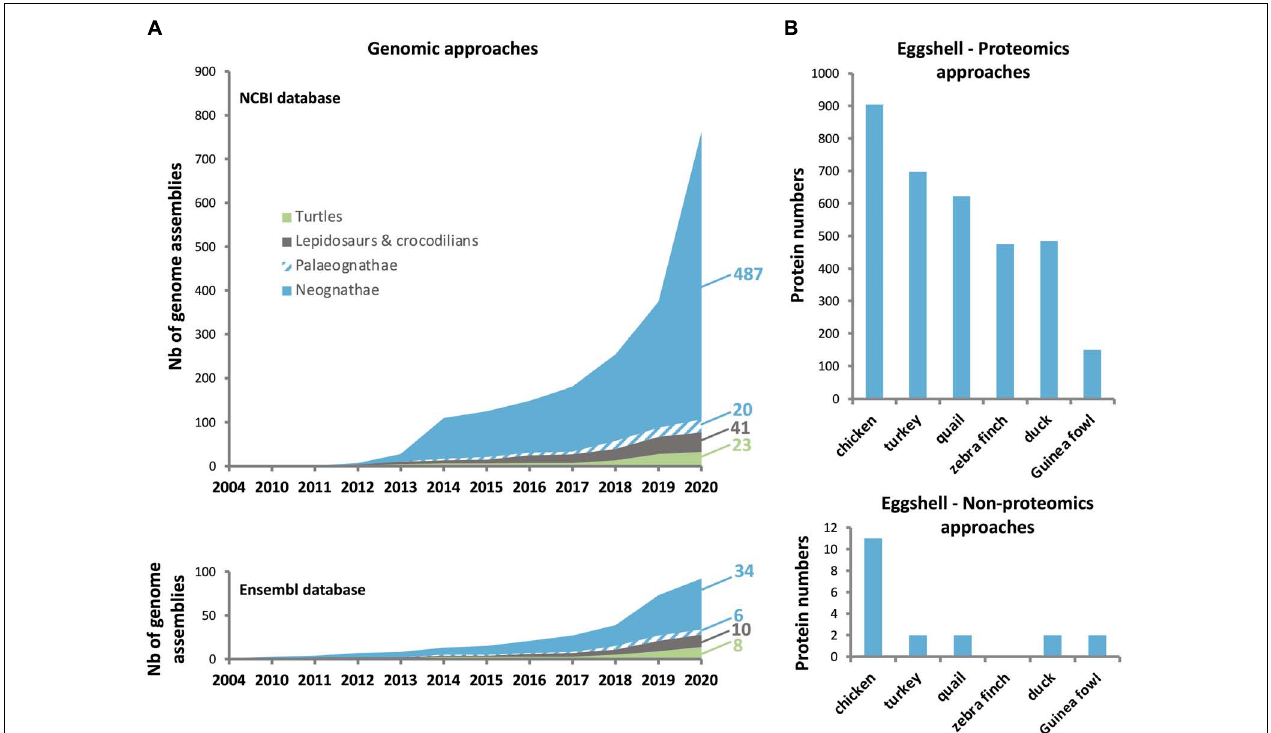
FIGURE 3 | Number of genomes sequenced in birds and reptiles, and the proteins identified in eggshell of different avian species. (A) Increase in number of bird and reptile genomes available in NCBI (upper: https://www.ncbi.nlm.nih.gov/), and Ensembl (lower: http://www.ensembl.org/index.html) databases since the chicken genome assembly in 2004. (B) Number of identified proteins using proteomics (upper) and non-proteomics (lower) approaches. Data were compiled from Hincke et al. (1995, 1999), Panheleux et al. (1999b), Gautron et al. (2001, 2007),Mann et al. (2006), Mann and Mann (2013, 2015), Mann (2015), Marie et al. (2015a), Zhu et al. (2019), and Le Roy et al.